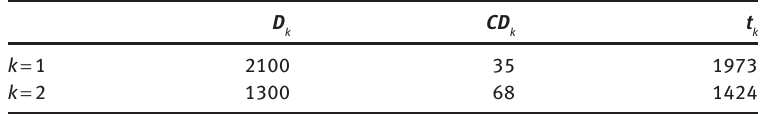
Table 1: Parameters of